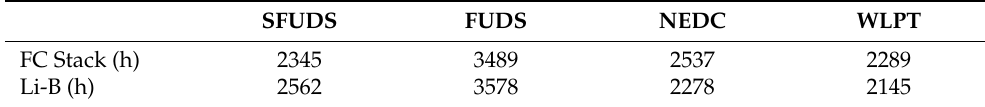
Table 11. Comparison of expected lifetime (Psplit3: δ =